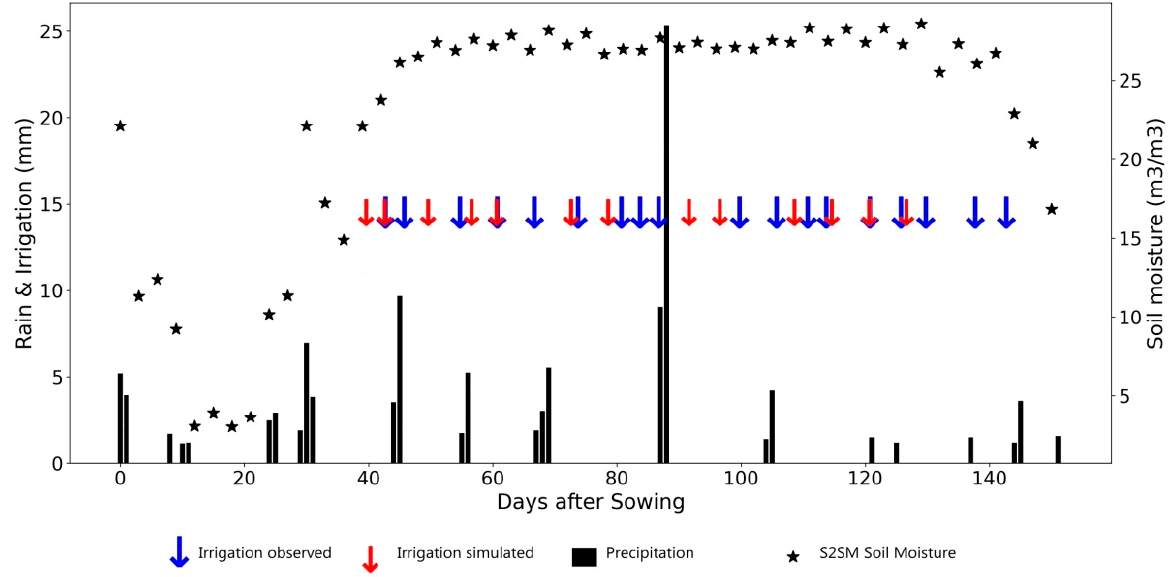
Figure 12. Same as Figure 12 for a potato field in Brandenburg in 2018 (high irrigation frequency and average irrigation amounts).